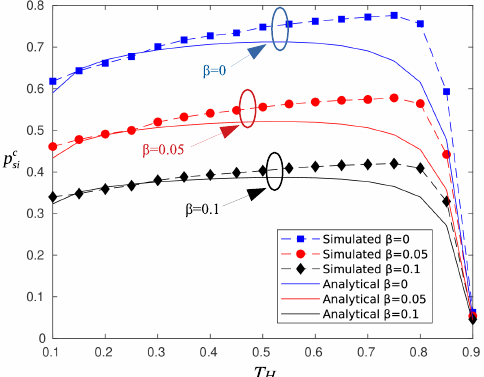
Figure 5. Probability of successful information reception p c